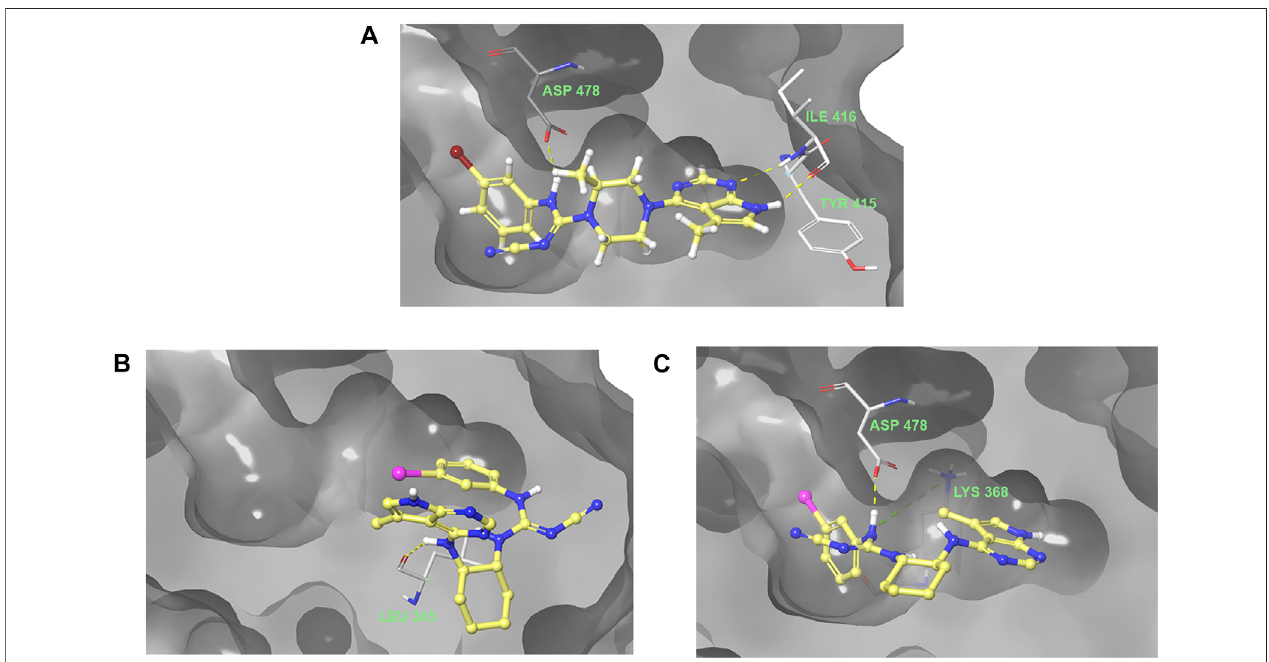
FIGURE 4 | Predicted binding poses of ligand 1 (A) , 24 (B) , and 26 (C) into the ATP-binding pocket of LIMK1.